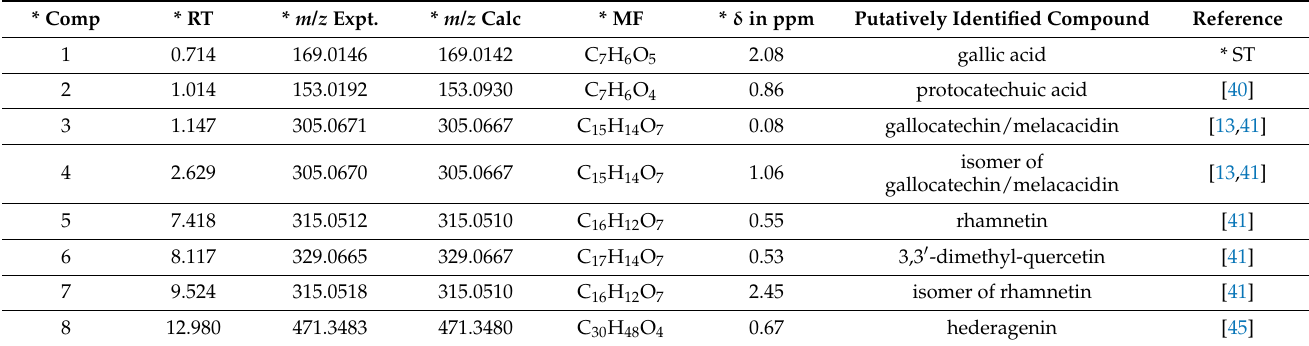
Table 2. Tentative assignment of compounds in Acacia implexa bark (crude